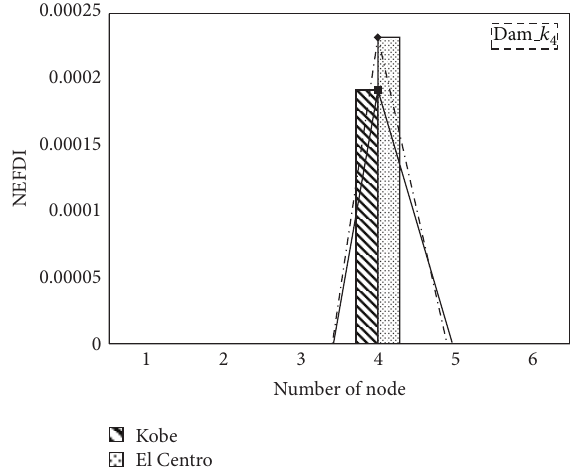
Figure 5: The NEFDI values of different nodes with different earthquake excitations.